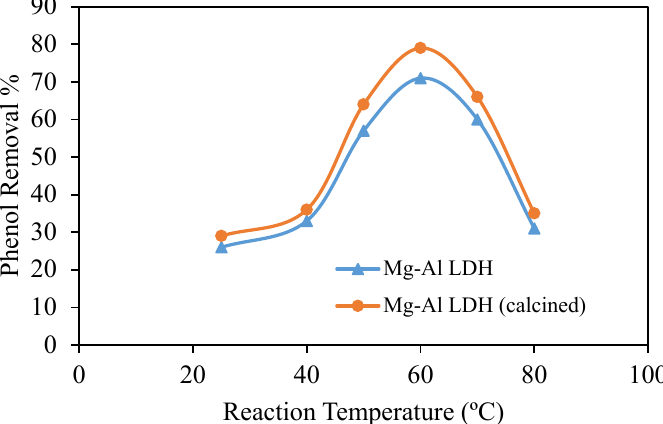
Fig.5. The removal of phenol at different reaction temperatures (reaction conditions: V = 100 mL, m = 0.05 g, initial phenol concentra- tion: 100 mg L -1 , reaction time = 45